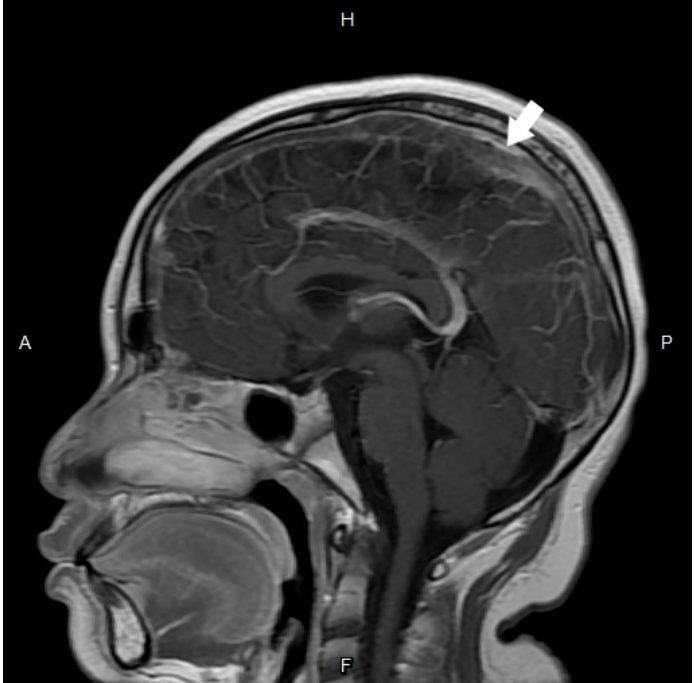
Figure 2. Magnetic resonance imaging with contrast revealed filling defect of the superior sagittal sinus (white arrow) that confirm the diagnosis of cerebral venous sinus thrombosis. A, anterior; P, posterior; H, head; F,